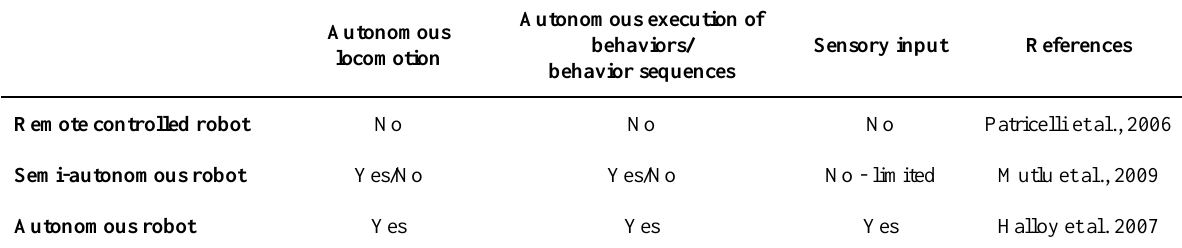
Specific Features of Robots Based on their Level of